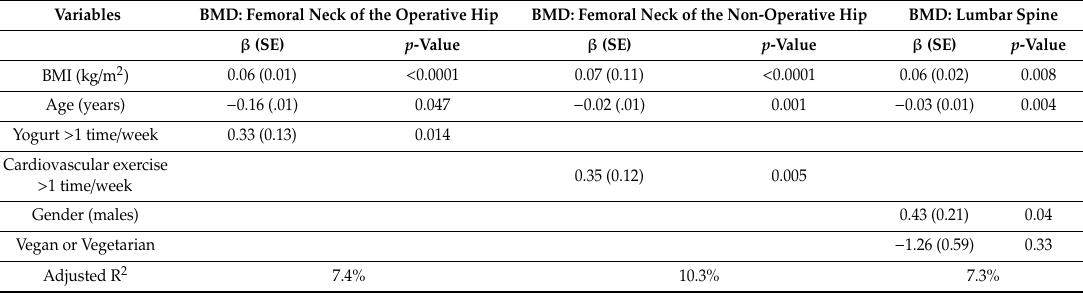
Table 4. Predictors of Bone Mineral Density according to a stepwise linear regression